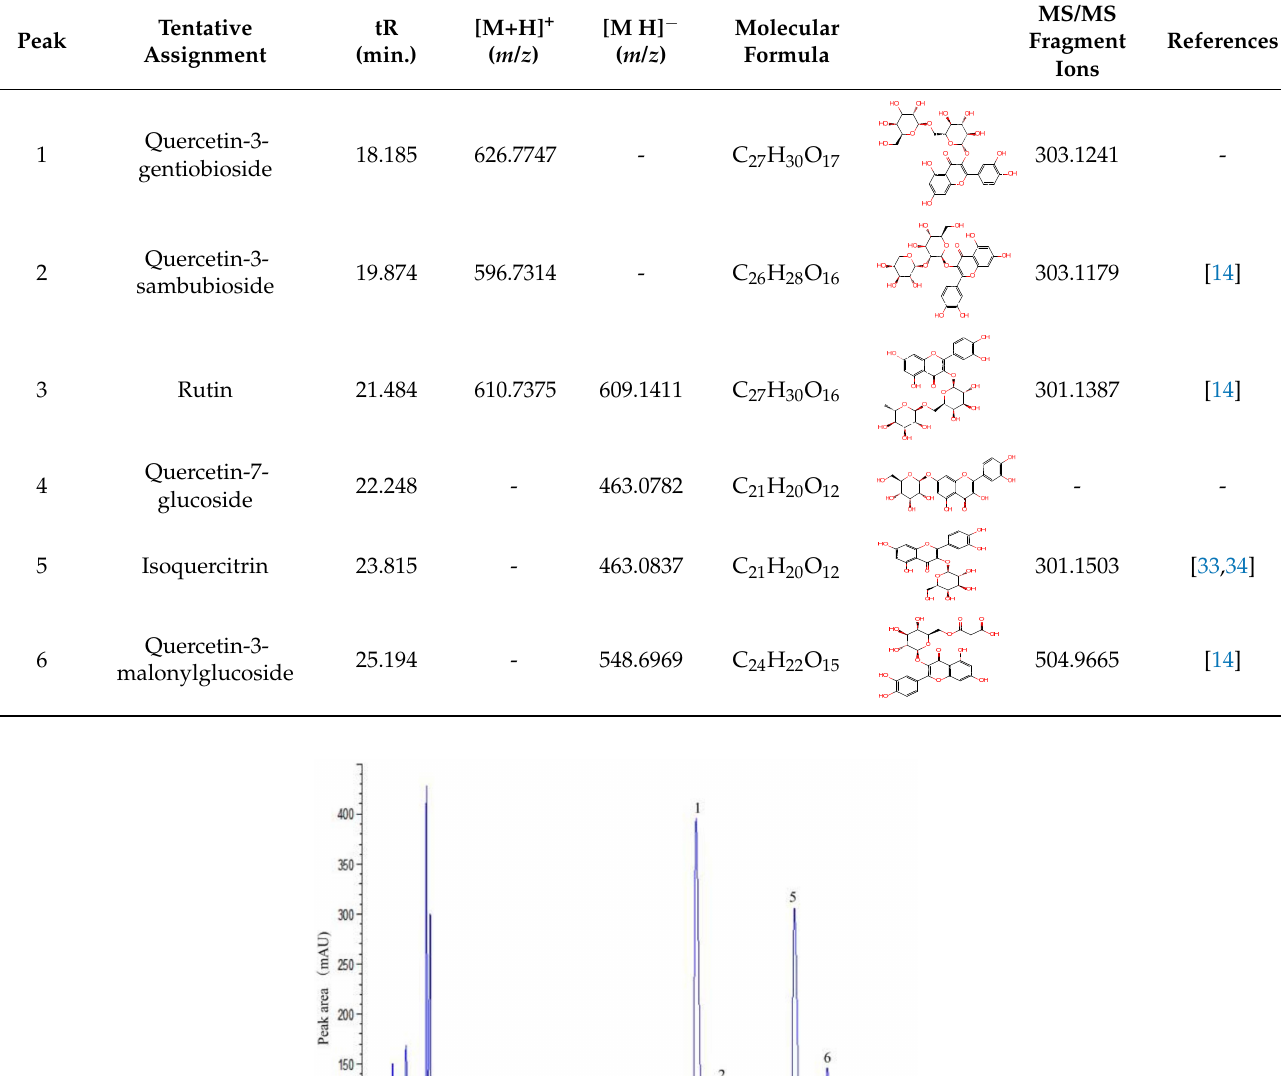
Table 1. Flavonoids compounds detected and characterized based on HPLC with HRMS analysis in positive and negative ionization modes.